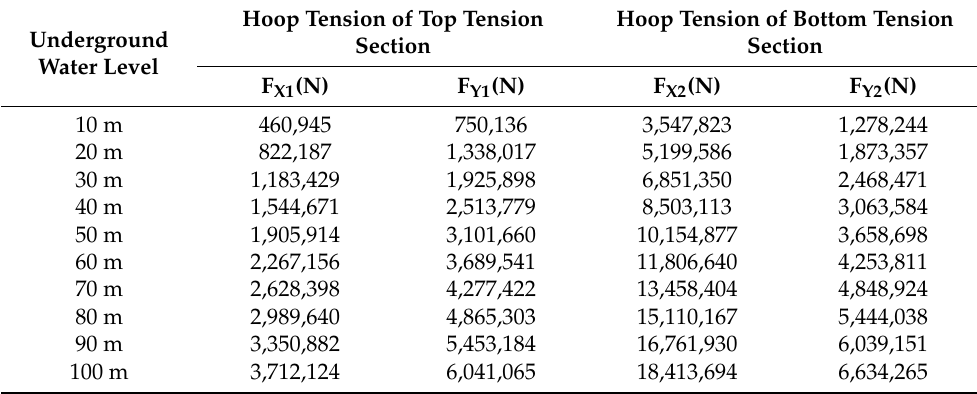
Figure 3. Comparison of the equivalent simulated water pressure and actual water-pressure loading. Table 1. Equivalent simulated hoop tension forces of the top and bottom sections with different under- ground water levels (based on Equations (4) and (5)). (Note: top half of the arch: α 1 = 32 ◦ , α 2 = 148 ◦ ; bottom half of the arch: α 1 = − 70 ◦ , α 2 = 250 ◦ ).